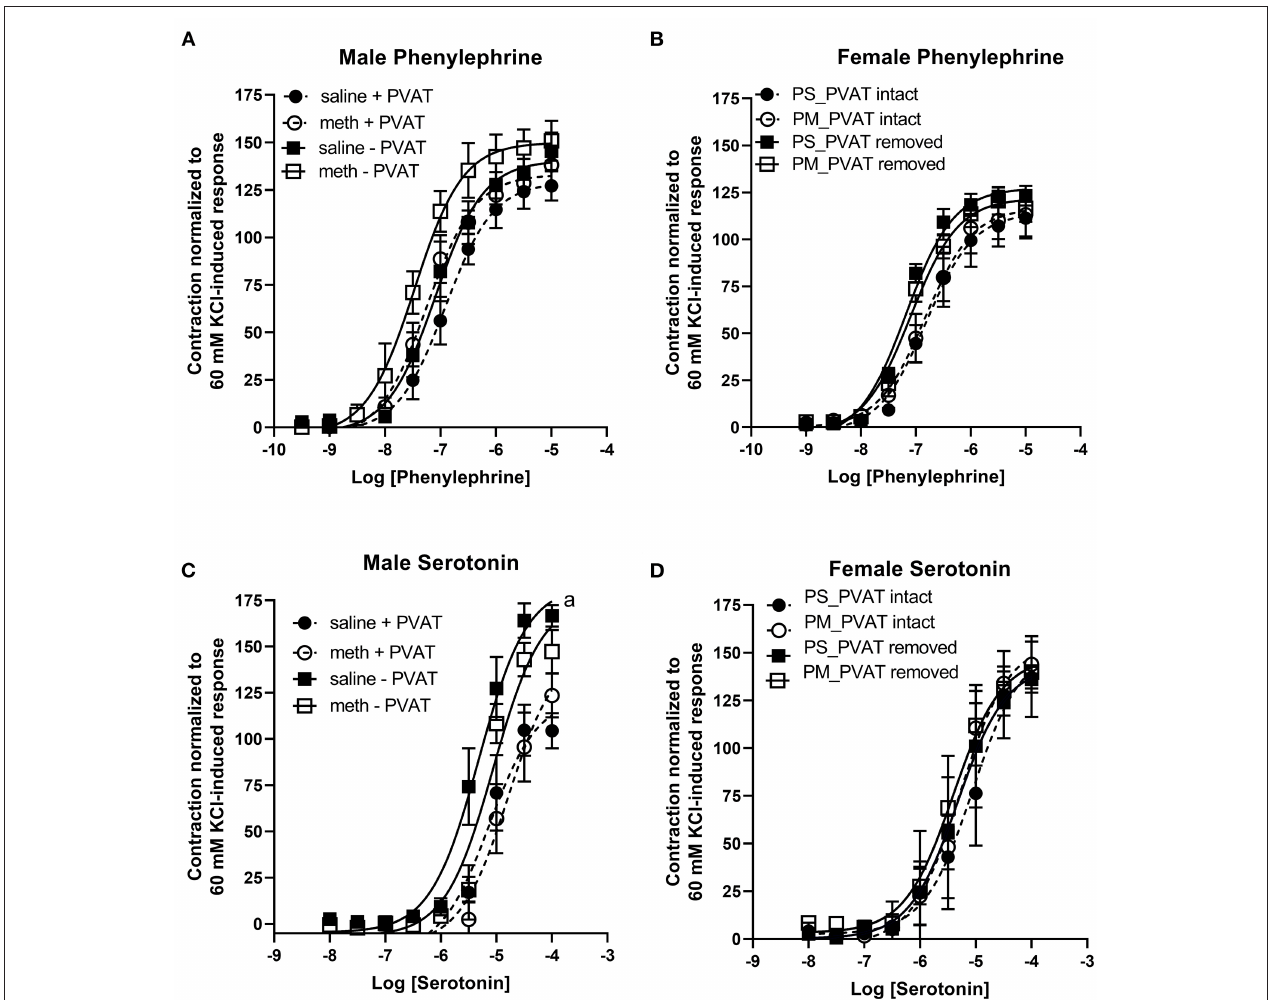
FIGURE 4 | Phenylephrine- and serotonin-induced contractile responses in male and female aortas following prenatal treatment with saline or methamphetamine. Neither fetal exposure to methamphetamine nor the presence of PVAT influenced phenylephrine-induced contraction in male (A) or female (B) aortas. Two way ANOVA indicated a significant effect [F = 5 (1, 18), p < 0.05] of methamphetamine on the pEC50 of serotonin-induced contraction in male aortas (C) and a significant effect [F = 21 (1, 18), p < 0.0005] of PVAT on the maximal contraction response to serotonin in male aortas (C) . Prenatal exposure to methamphetamine and the presence of PVAT had no impact on serotonin-induced contractile responses in female aortas (D) . a indicates a significant difference ( p < 0.005) in the maximal response compared to aortas from saline treated rats with PVAT removed (- PVAT). Data represent the mean ± SEM of 5–6 male animals and 3–6 female